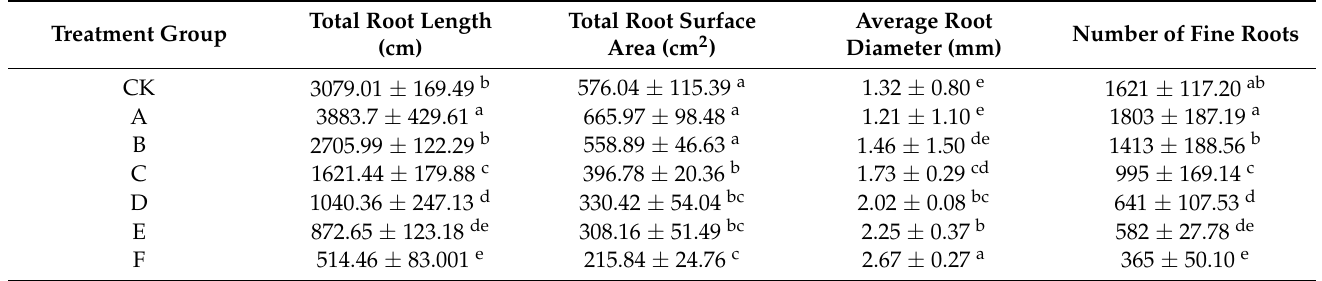
Table 2. Changes of root structure in seedlings of K. paniculata .